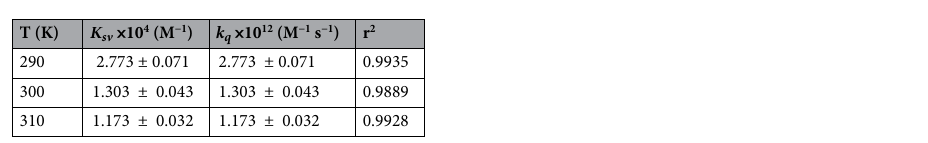
Table 2. Stern–Volmer and quenching rate constants for BSA ‒ 5A8HQ interaction.